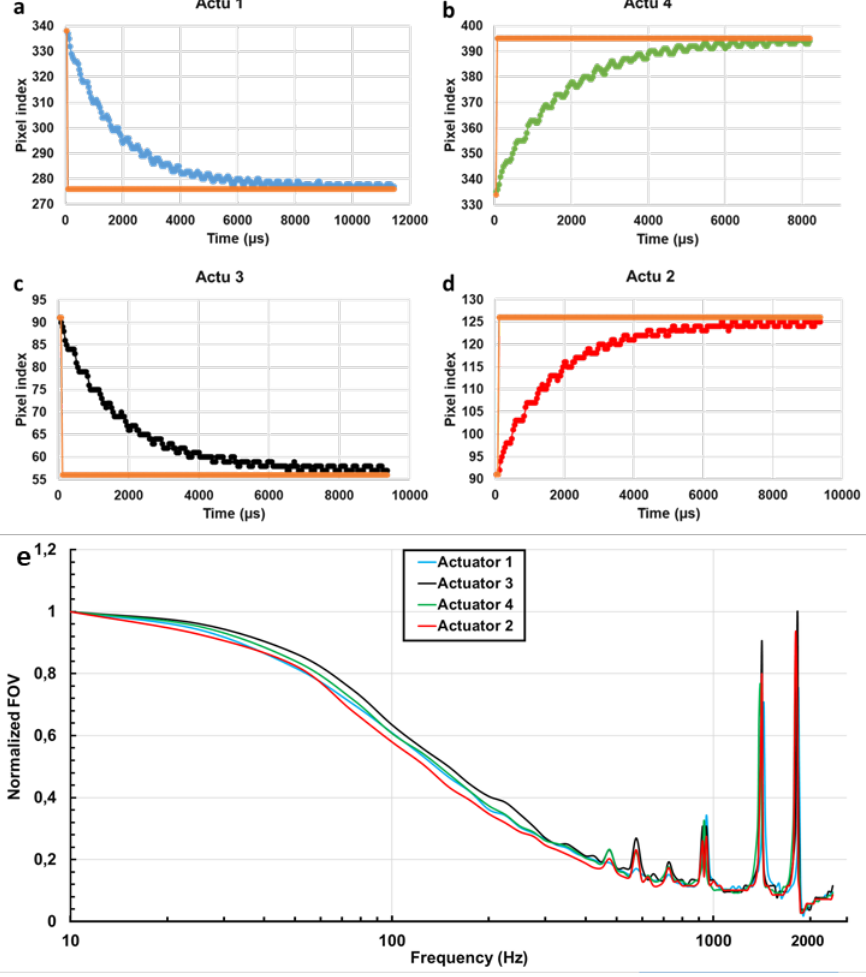
Figure 7. The dynamic responses of the MEMS mirror actuators. Step response of the MEMS mirror four actuators ( a – d ) in the rise phase (heating up). Frequency response of the four actuators ( e ) corresponding to the Normalized displacement of the beam (field of view, FOV) with the frequency variation at a fixed voltage of 1.5 V.